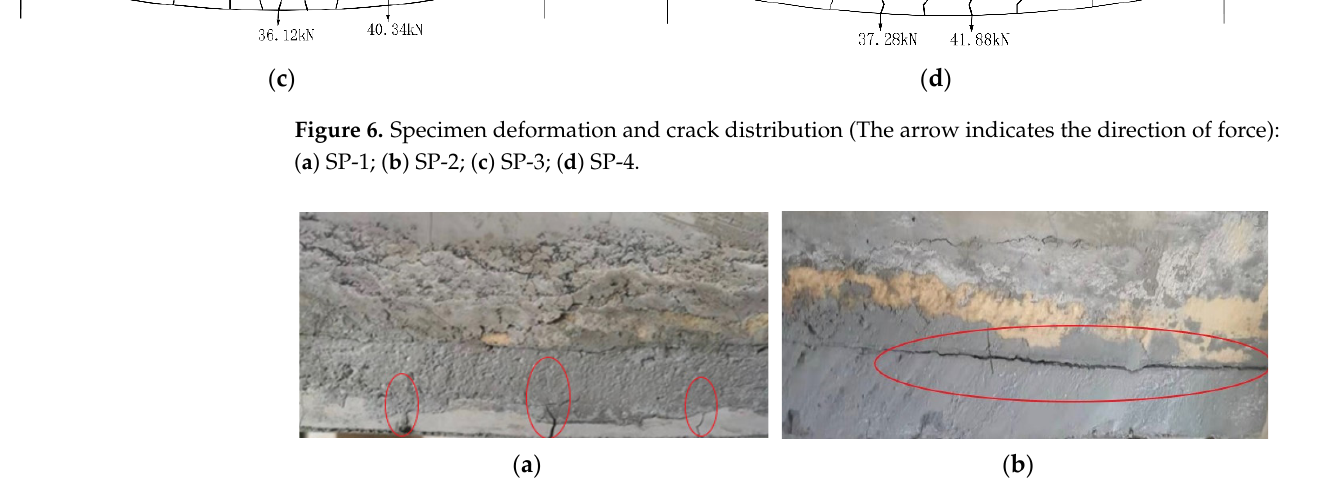
Figure 7. Failure phenomena of SP-1 specimen (Failure phenomenon is in the red circle): ( a ) Local cracking phenomenon; ( b ) Local debonding phenomenon.